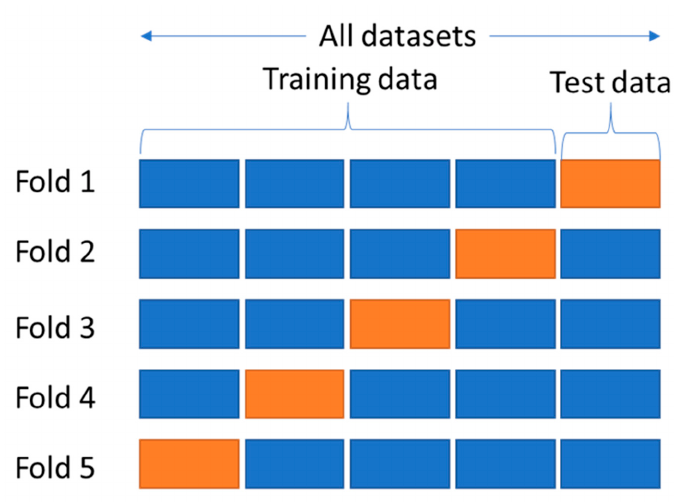
Figure 4. Data set division in fivefold cross-validation.